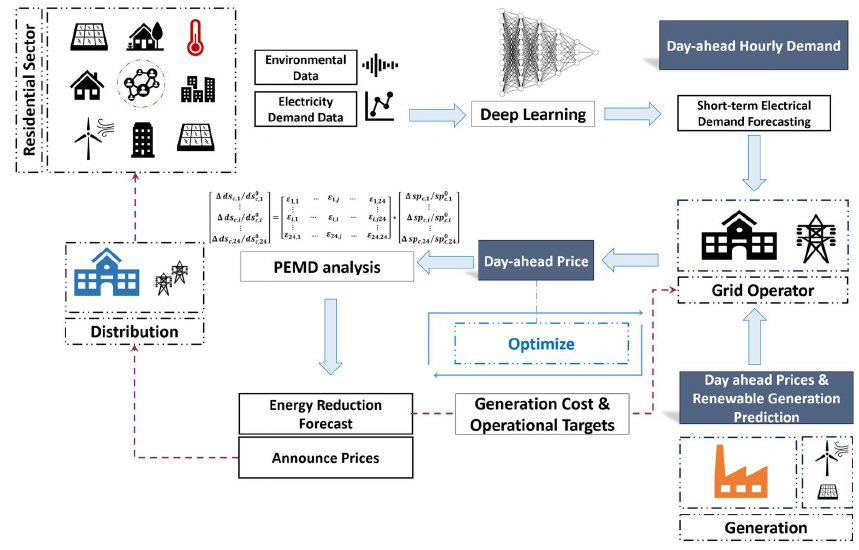
Figure 4. Proposed day-ahead demand response model for Jordan in this study.